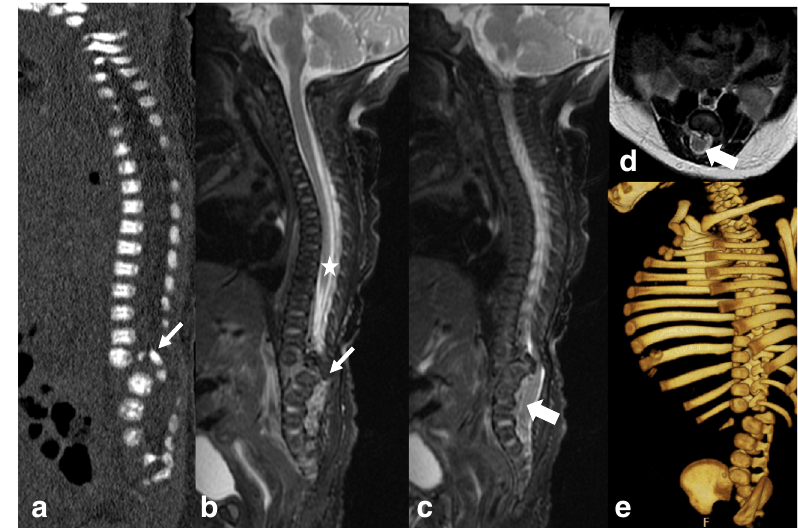
Fig. 7 a - d : Segmental spinal dysgenesis in a neonate: Sagittal CT reconstruction ( a ) and sagittal T2 MR ( b ) images of the spine in the neonate with congenital paraplegia show absence of L1 and posterior dislocation of a hypoplastic L2 vertebra into the spinal canal ( arrows on a and b ). The spinal cord ( star on b ) is absent over the affected segments of the spine, but is thick and abnormally low further distally ( block arrows on c and d ). The 3D bony reformats from concomitantly performed CT ( e ) redemonstrate absence of L1 and hypoplasia of the posteriorly dislocated